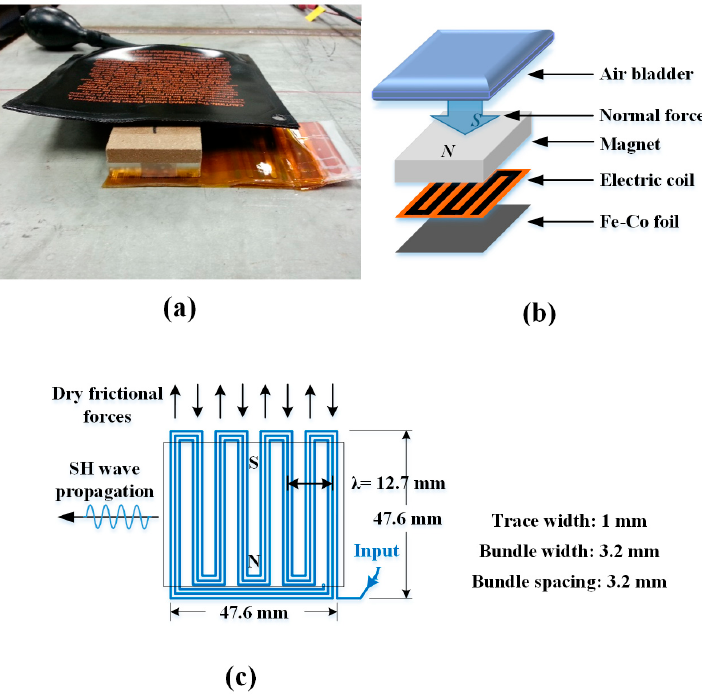
Figure 3. ( a ) MST prototype; ( b ) assembly of the MST; and ( c ) layout of permanent magnet